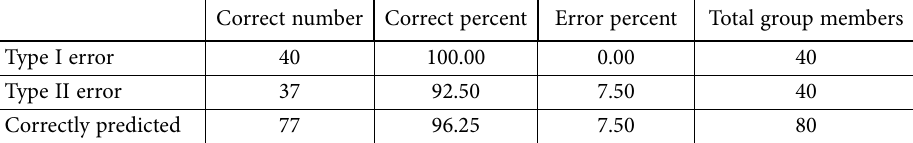
Table 5. Model prediction for one year prior to bankruptcy or insolvency (source: authors’ processing) Correct number Correct percent